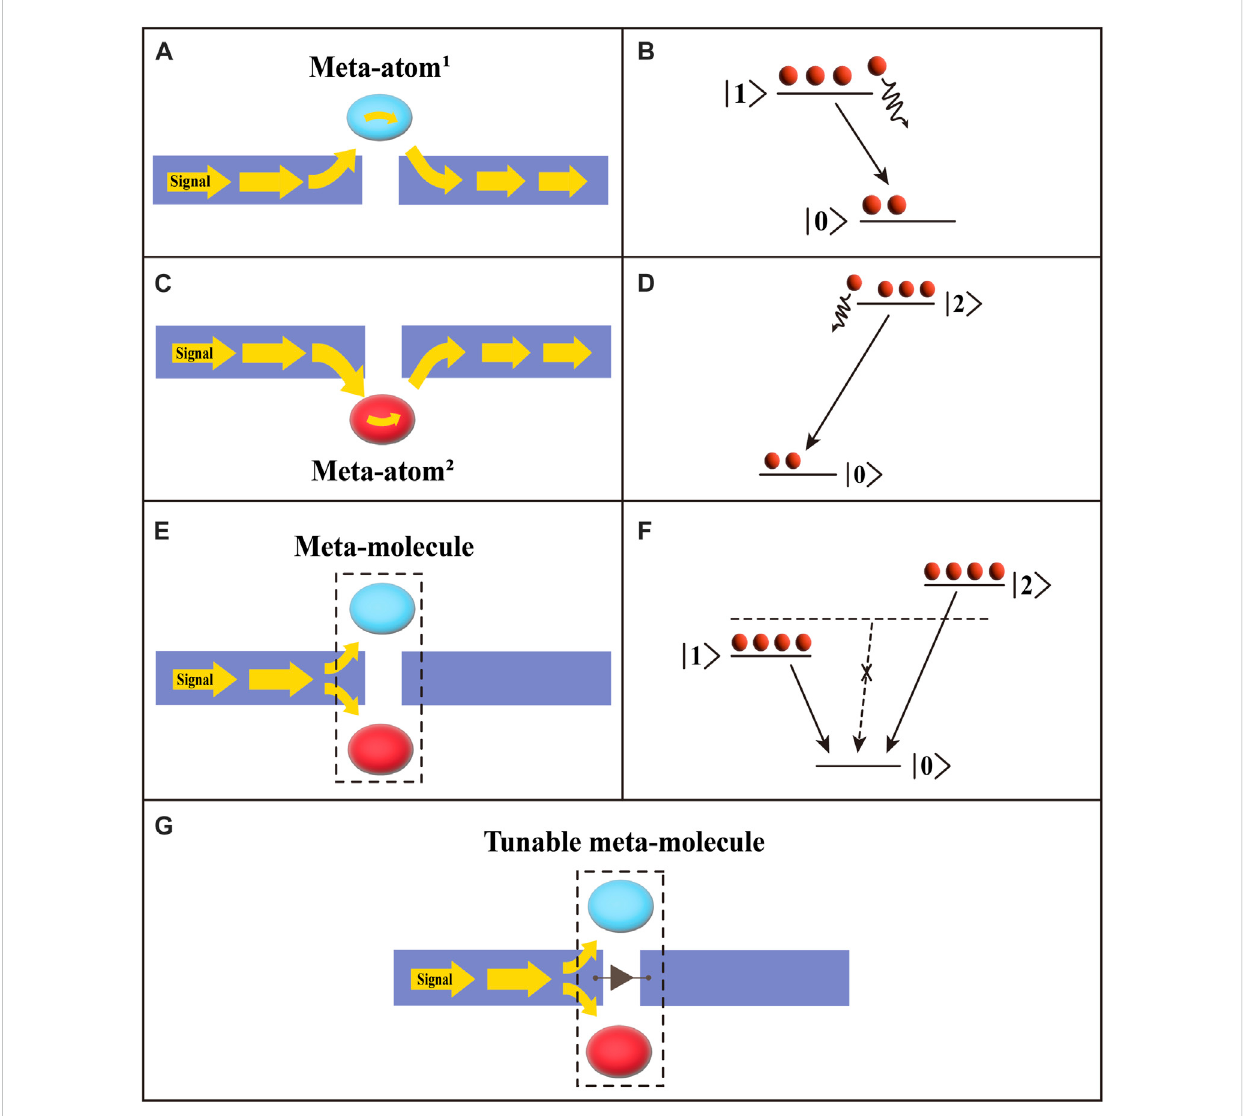
FIGURE 1 Schematic diagram of (A) an upper side-coupled meta-atom 1 analogous to (B) a two-level atomic system. Schematic diagram of (C) another lower side-coupled meta-atom 2 analogous to (D) a two-level atomic system with a different excited state. Schematic diagram of (E) a meta-molecule consisting of two coexistent symmetrically side-coupled meta-atoms, analogous to (F) a three-level V-type atomic system. (G) Schematic diagram of a tunable SEC-like